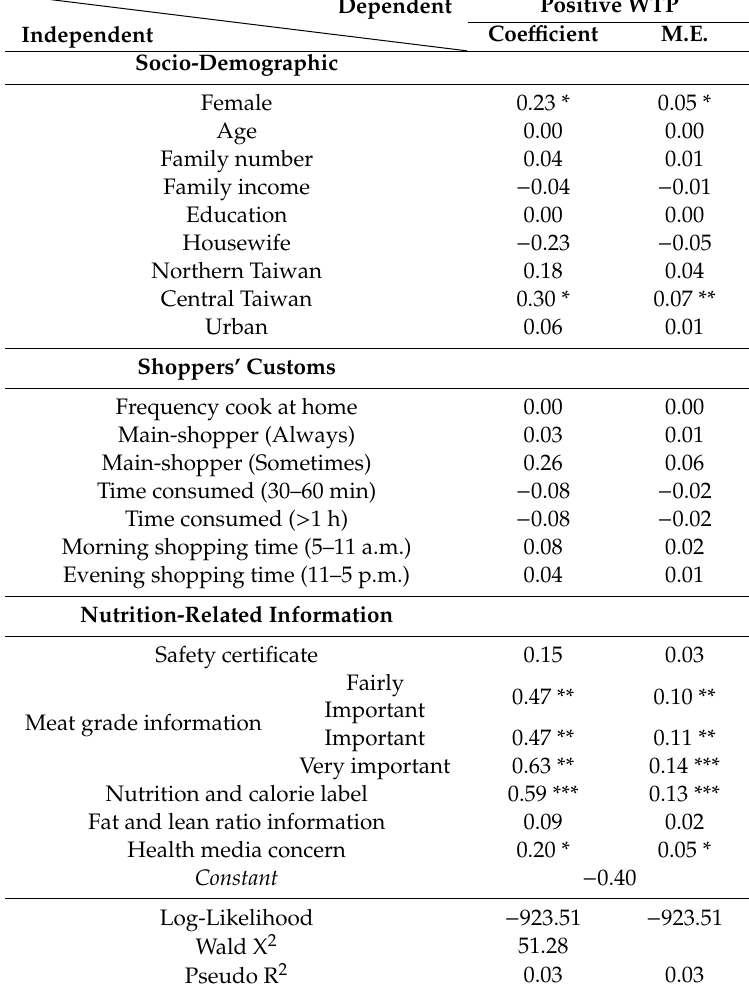
Table 2. The summary of logit model and marginal e ff ect results for WTP an extra for nutrition information ( N =